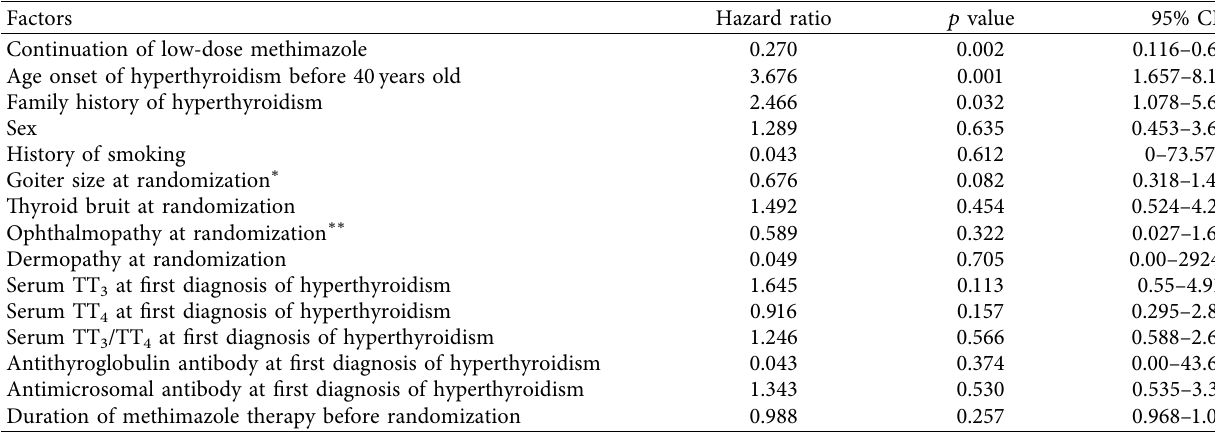
Figure 3: The Kaplan-Meier curve shows that 83 patients who were randomly assigned to continue low-dose methimazole therapy (CONT- MMI) represented in a dotted line had significantly higher recurrence-free survival than 90 patients who were randomly assigned to discontinue low-dose methimazole therapy (DISCONT-MMI) represented in a solid line ( p � 0 . 0009) with a Cox hazard ratio of 0.27 (95% CI � 0.12–0.62). Table 3: Univariate analysis of factors associated with recurrent hyperthyroidism in 173 Graves’ hyperthyroid patients who were eligible for analysis at the end of the study.